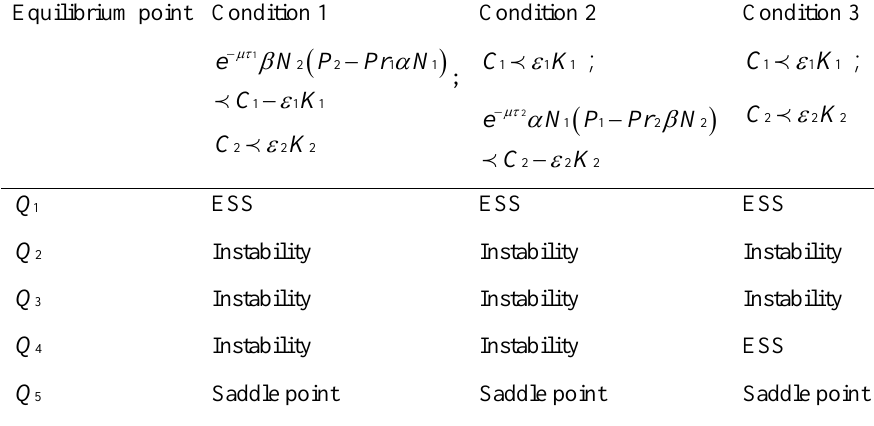
Table 4 The evolutionary stability analysis under different conditions.